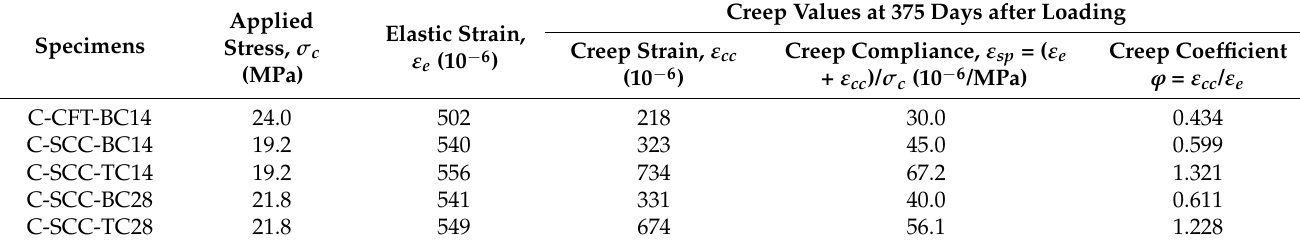
Table 5. Basic and total creep results of